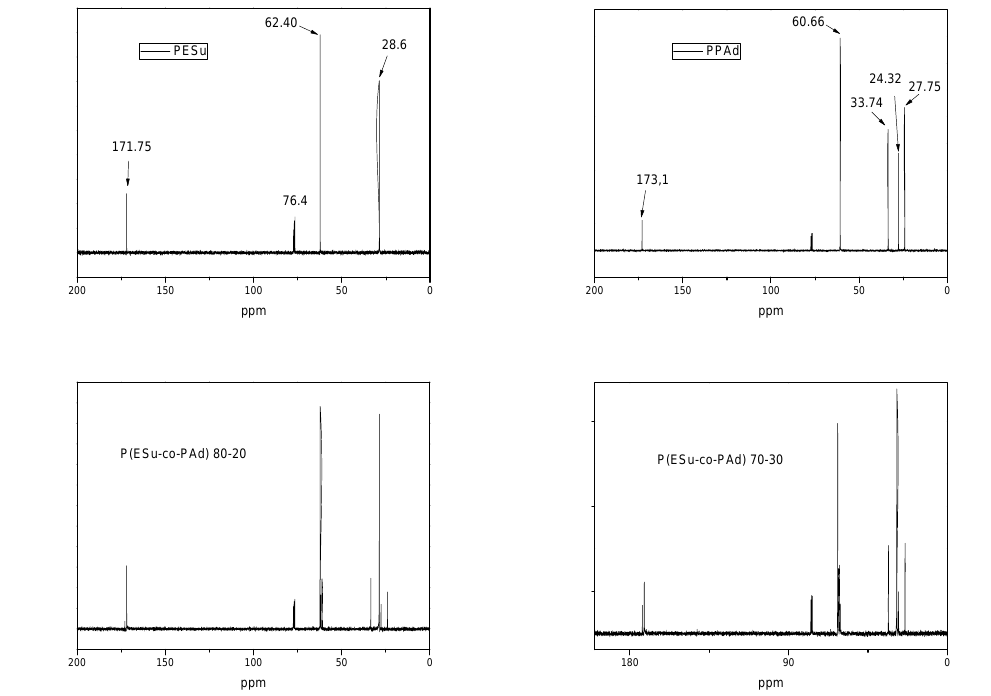
Figure 3. 13 C-NMR spectra of PESu, PPAd and their P(ESu-co-PAd) copolymers.